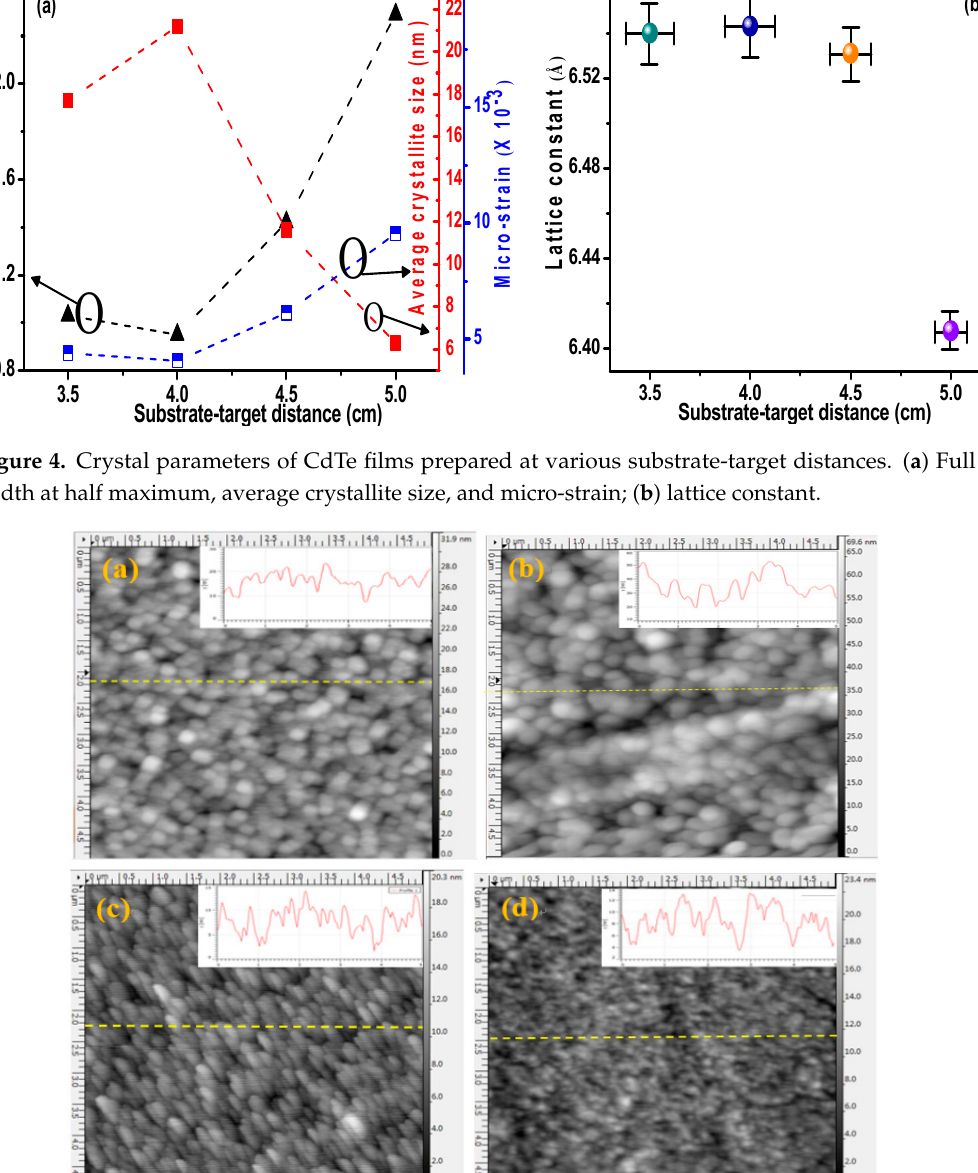
Figure 6. Three-dimensional surface morphologies of CdTe films deposited at different substrate- target distances, D ts . ( a ) 3.5 cm; ( b ) 4 cm; ( c ) 4.5 cm; and ( d ) 5 cm. Table 3. Surface morphology parameters of CdTe films prepared at different substrate-target distances. D ts (cm) Average Grain Size (nm) RMS Roughness (nm) 3.5